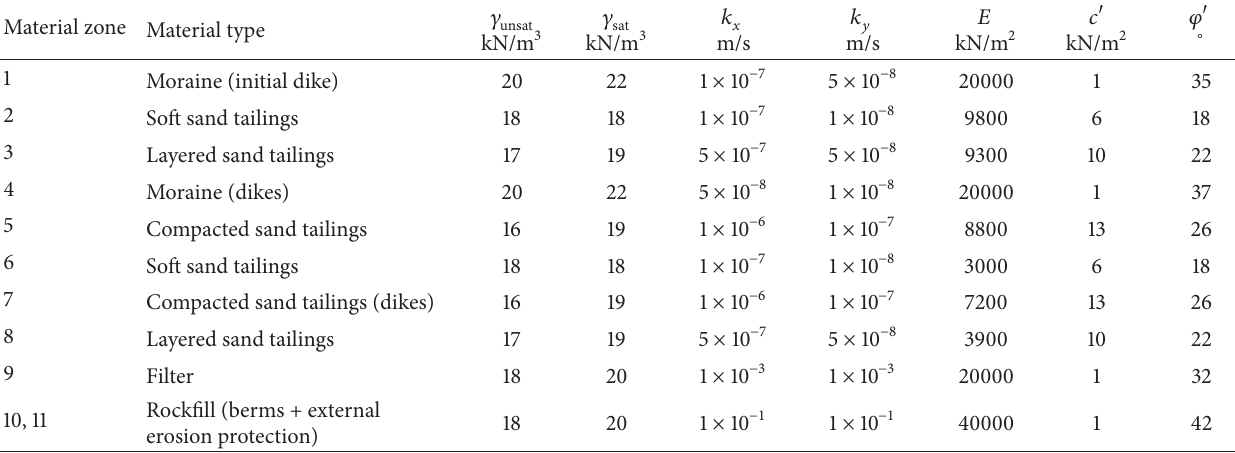
Table 1: Parameters of the Mohr Coulomb model [3, 42–45].